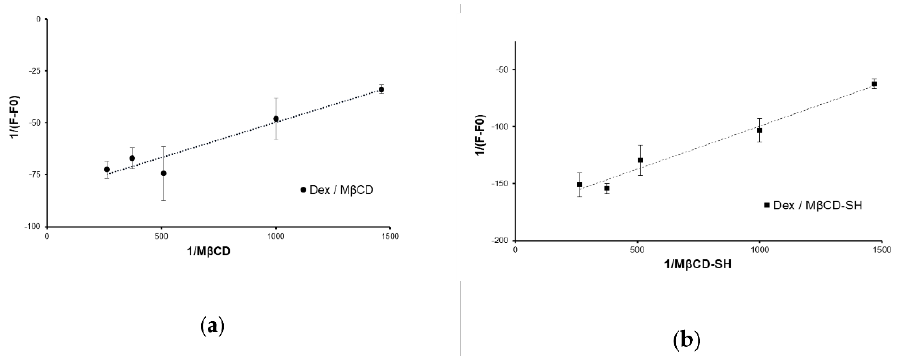
Figure 3. Benesi – Hildebrand plot for Dex/MβCD ( a ) and Dex/MβCD -SH ( b ). Each point is the mean ± standard deviation of 3 values.